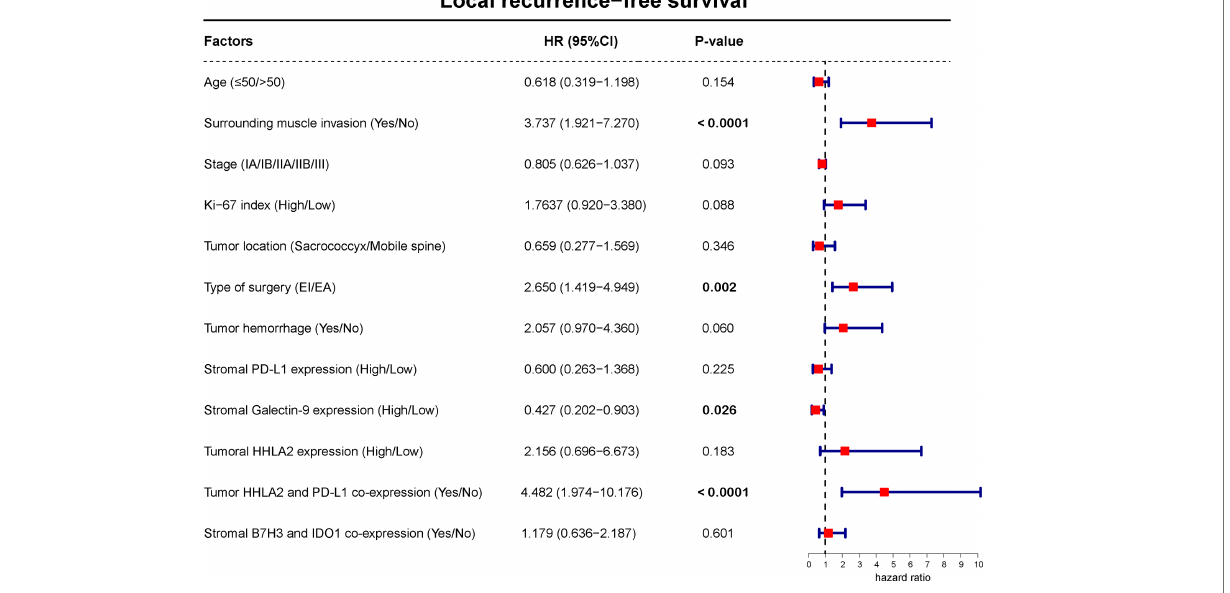
FIGURE 10 | Multivariate Cox regression model including factors that were signi fi cant in univariate analysis for LRFS of spinal chordoma patients. The boxes indicate the hazard ratio, and the horizontal lines represent the 95% CI. Factors found to independently predict LRFS had P values in bold (less than 0.05). LRFS, local recurrence-free